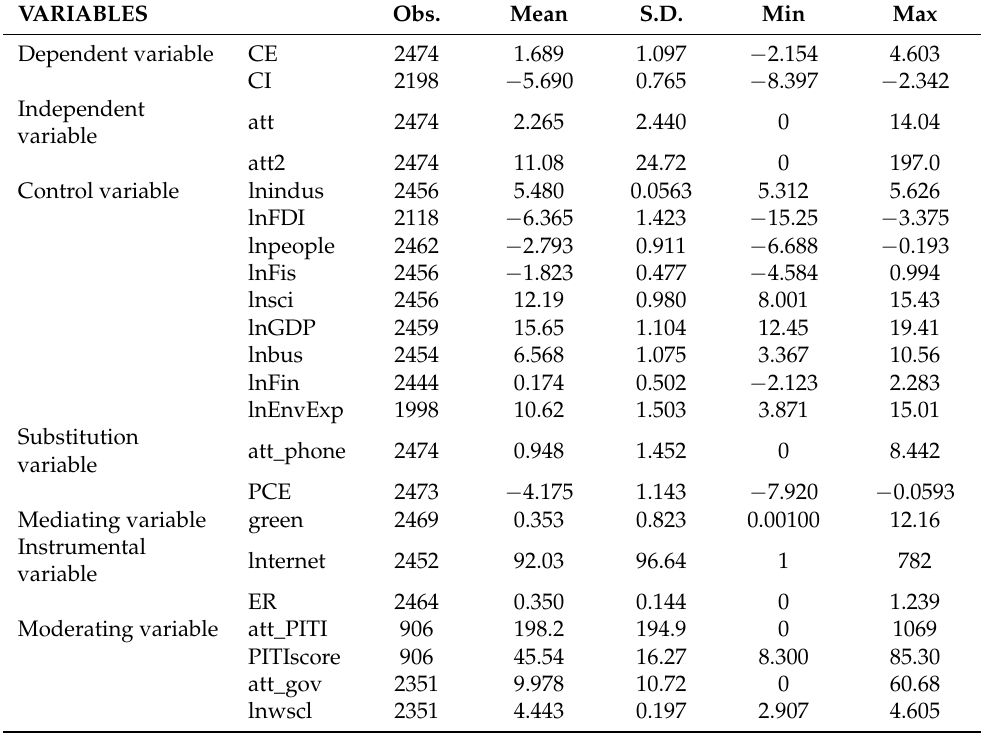
Figure 1. The geographical distribution of the sample cities. Table 1. Descriptive